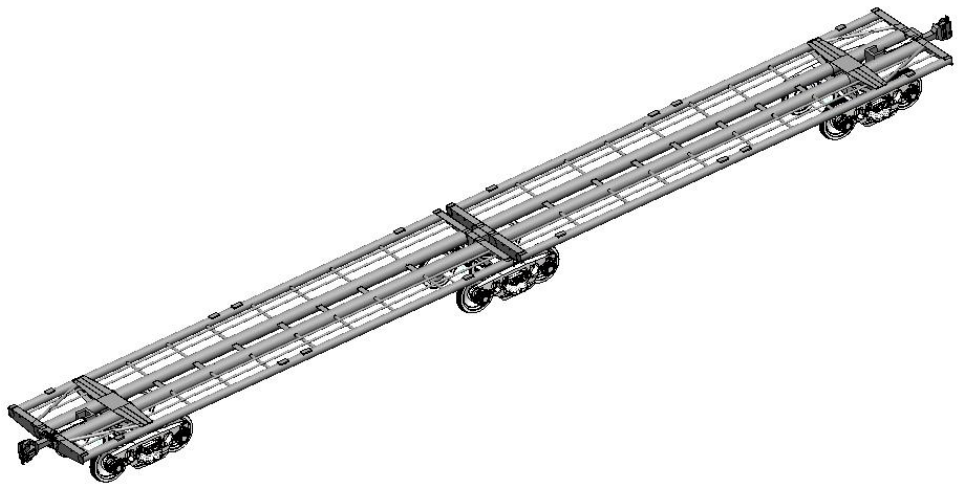
Figure 1. The articulated flat wagon of circular pipes.